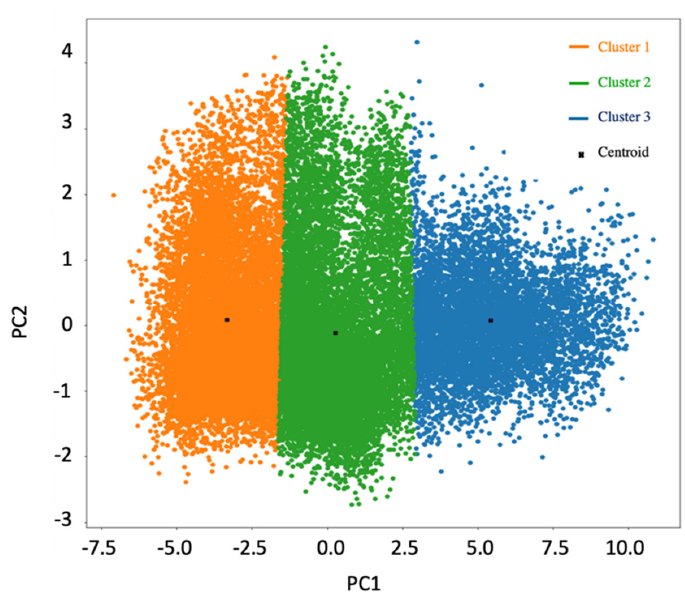
Figure 9. Variance in CP1 and CP2.